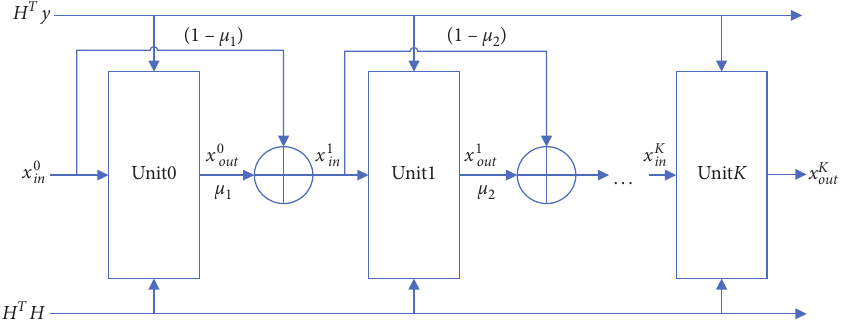
Figure 4: The overall structure of MsNet.